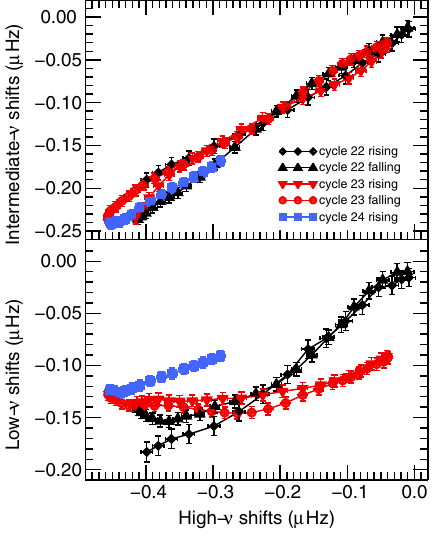
Fig. 37 Frequency shifts in the mid-frequency range ( upper panel ) and low-frequency range ( lower panel ) plotted as a function of the frequency shifts in the high-frequency range for cycles 22, 23, and 24. The frequency shifts have been smoothed to remove the signature of the 2-year cycle. The frequency ranges are identical to those in Fig. 36. (Image courtesy of Anne-Marie